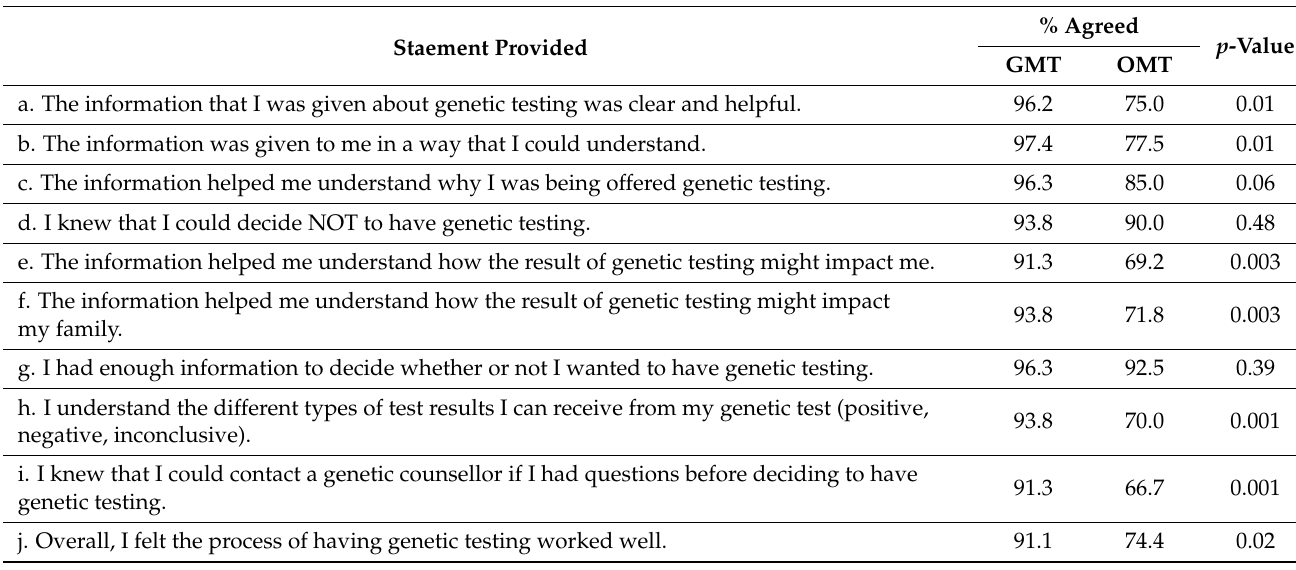
Table 3. Responses to experience and understanding of genetic testing questions.